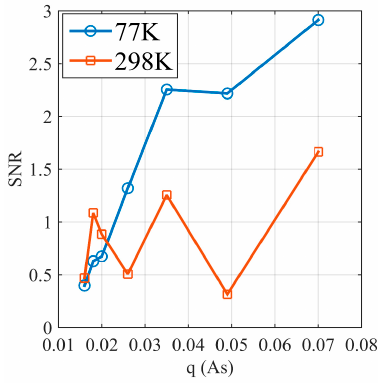
Figure 14. SNR of MRS signals at 298 K and 77 K.